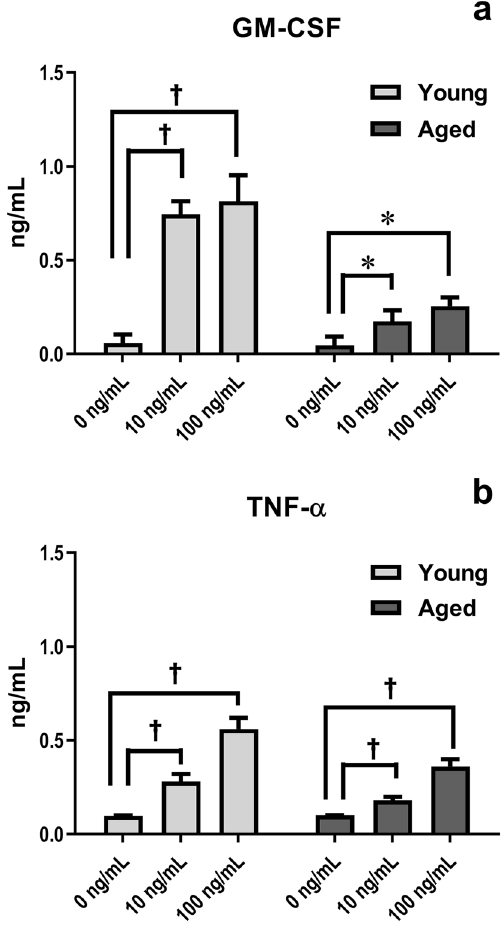
Figure 5. Cytokine production by cultured stromal cells after LPS treatment. The productions of GM-CSF ( a ) and TNF-α ( b ) by cultured stromal cells obtained from young and aged mice after LPS treatment are shown. The concentrations of GM-CSF and TNF-α in the culture medium were determined using GM-CSF- and TNF-α- specific ELISA. Each bar represents the mean ± SD obtained from three culture wells. *P < 0.05, † P <